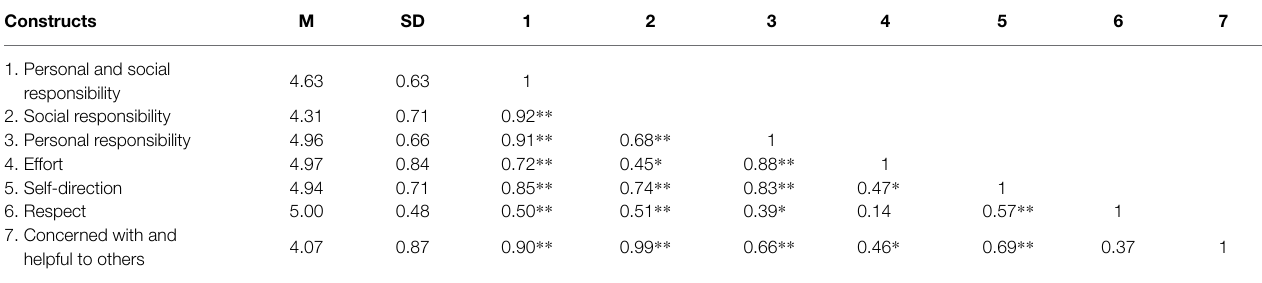
TABLE 4 | Correlation of variables of PSR. Constructs